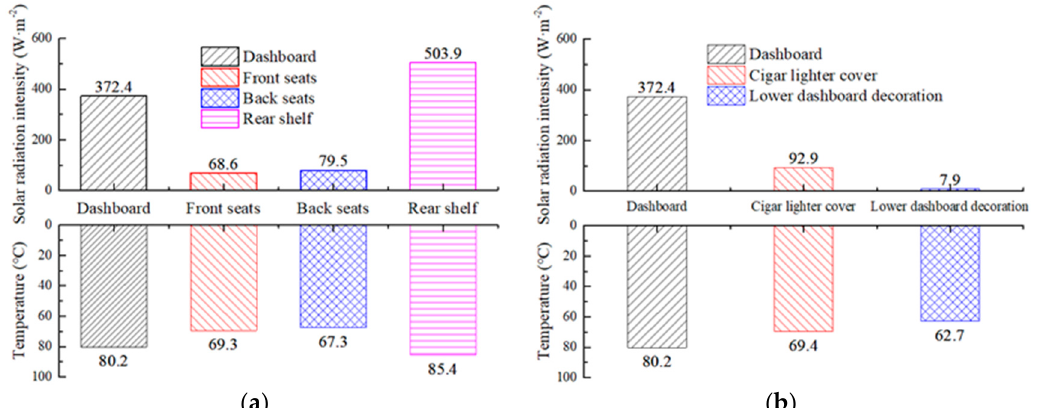
Figure 7. Overall external factors distribution of weathering: ( a ) horizontal distribution of external factors; and ( b ) vertical distribution of external factors.